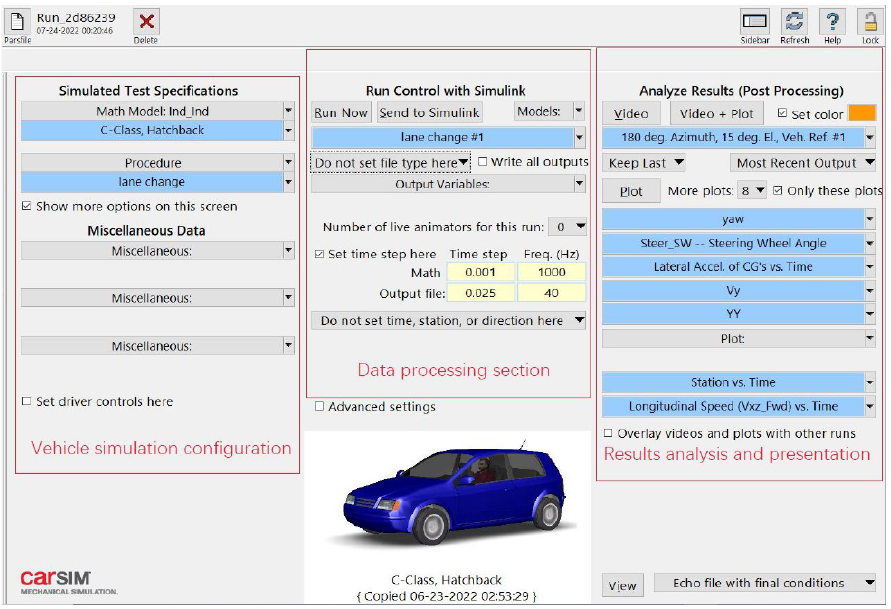
Figure 5. Main interface of the CarSim simulation software.